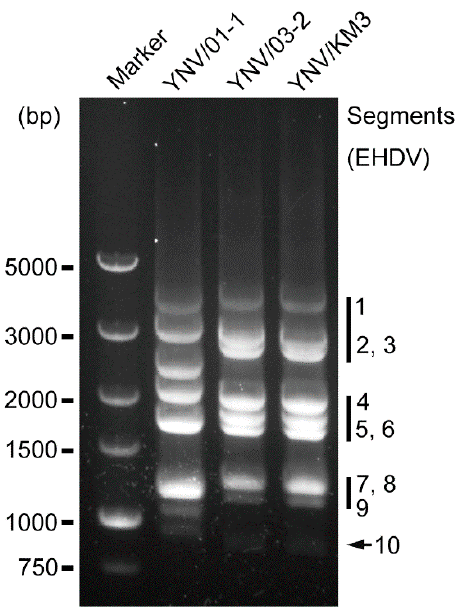
Figure 1. Electrophoresis gel displaying genomic fragments of three viruses isolated from Culicoides spp. in Yunnan Province, China. DNA marker and DNA samples of YNV/01-1 (BAV), YNV/03-2 (EHDV-7), and YNV/KM3 (EHDV-1) were separated by electrophoresis in 1% agarose gel. The EHDV segments are annotated on the right.